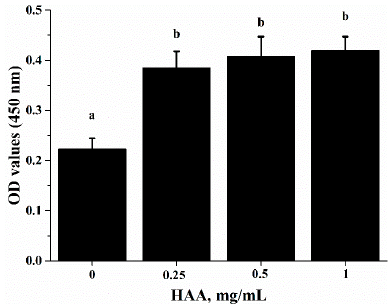
Figure 5. Effect of in vitro HAA supplementation on CD3/CD28-induced lymphocyte proliferation. Splenocytes isolated from C57BL/6 mice were incubated in the presence of HAA at 0, 0.25, 0.5 or 1 mg/mL for 4 h and then cells were stimulated by anti-CD3 (5 mg/mL)/anti-CD28 (1 mg/mL) for 72 h. Cell proliferation was measured by Cell Counting Kit-8(CCK-8) assay. Values are means ± SD, n = 10. Means in a row without a common letter significantly differ as determined by one-factor ANOVA, p <